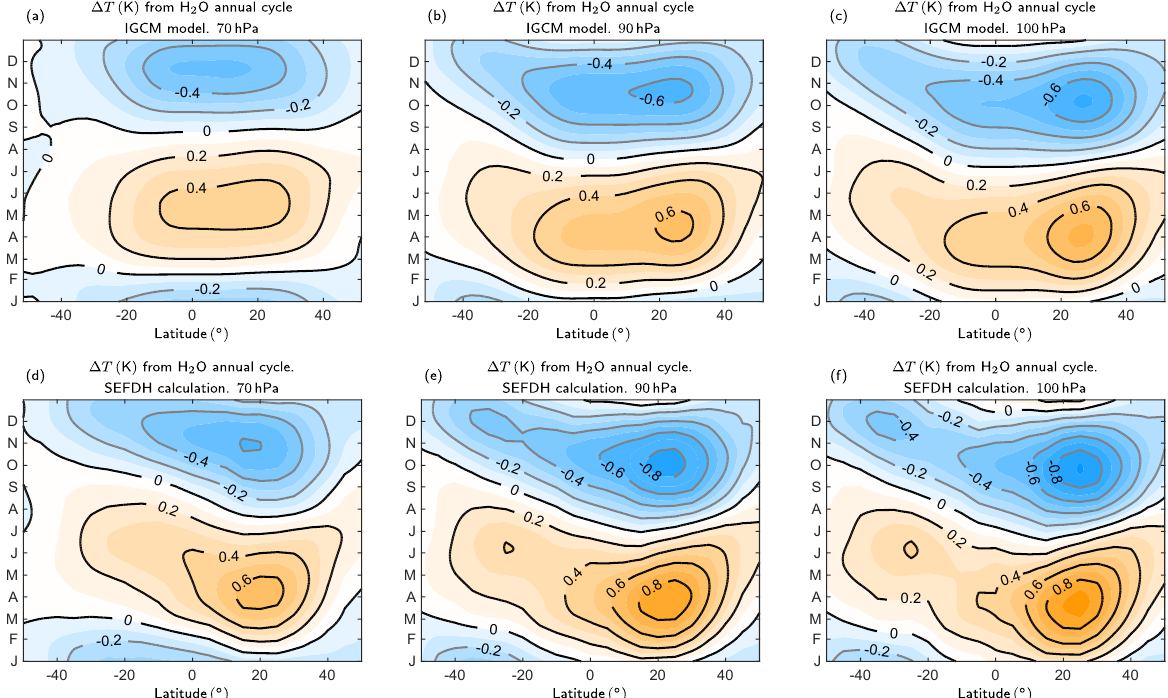
Figure 11. Temperature changes (K) calculated using the idealized dynamical model (IGCM) with an annual cycle in water vapour at (a) 70hPa, (b) 90hPa, and (c) 100hPa. Temperature change from the SEFDH calculation (same as Fig. 5b–d) at (d) 70hPa, (e) 90hPa, and (f) 100hPa for